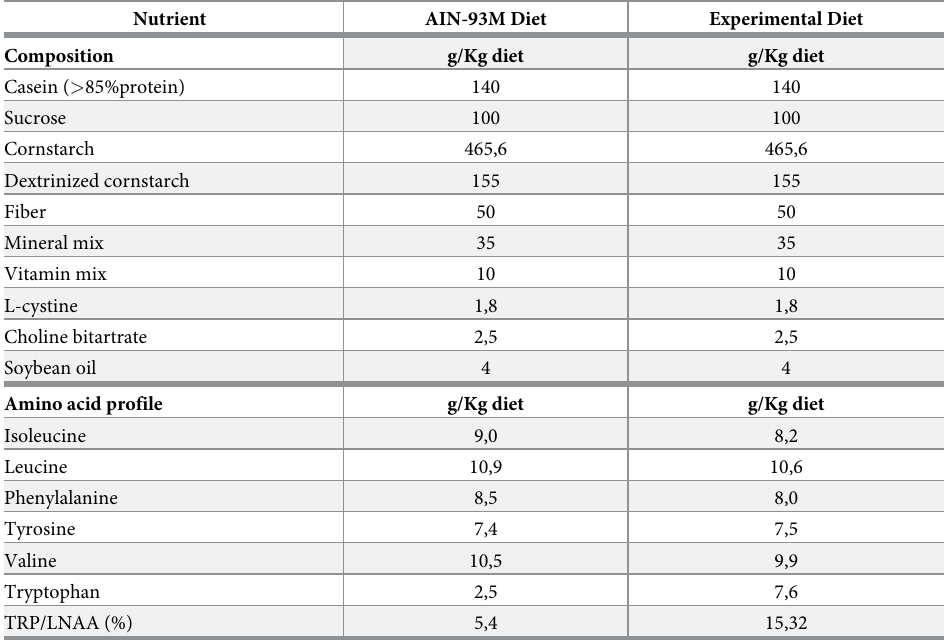
Table 1. Composition and typical amino acid profile of control and experimental diets. Nutrient AIN-93M Diet Experimental